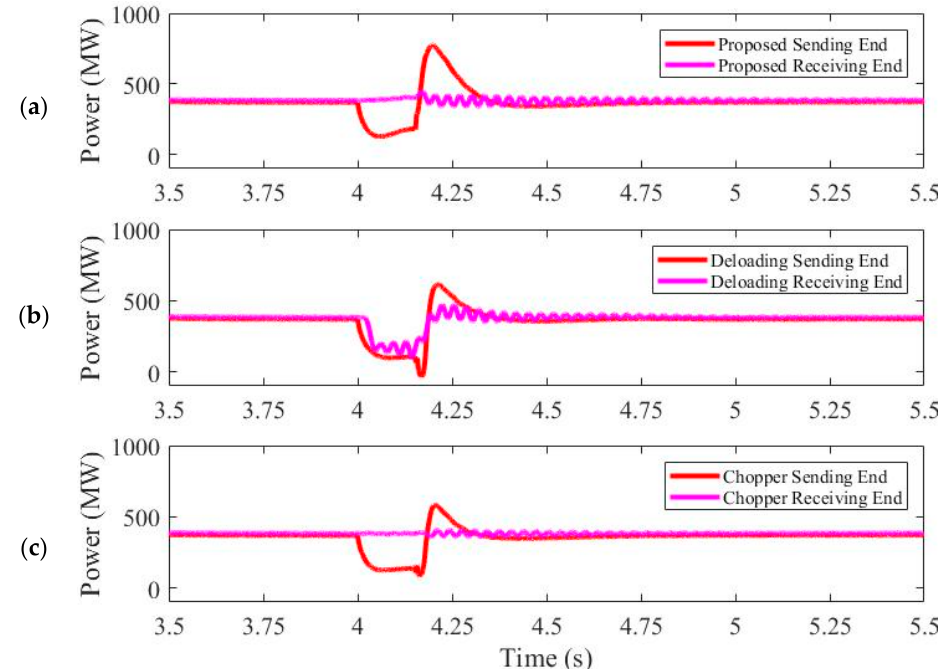
Figure 18. Simulation results of the on-shore fault scenario with a 2.95 Ω fault resistance . ( a ) Off-shore frequency for each simulation case. ( b ) DFIG rotor turbine acceleration for each simulation case. ( c ) Comparison of DFIG rotor turbine speed by the participation coefficient.